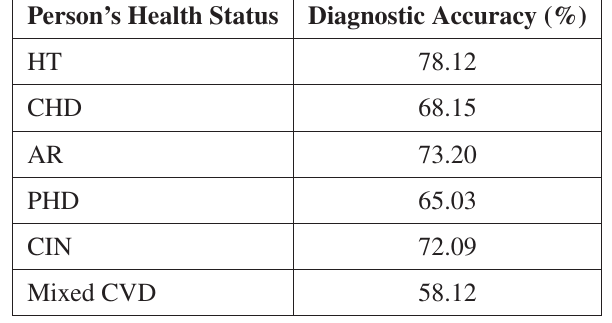
Table 6. Diagnostic Accuracy of HBFIN in CVD